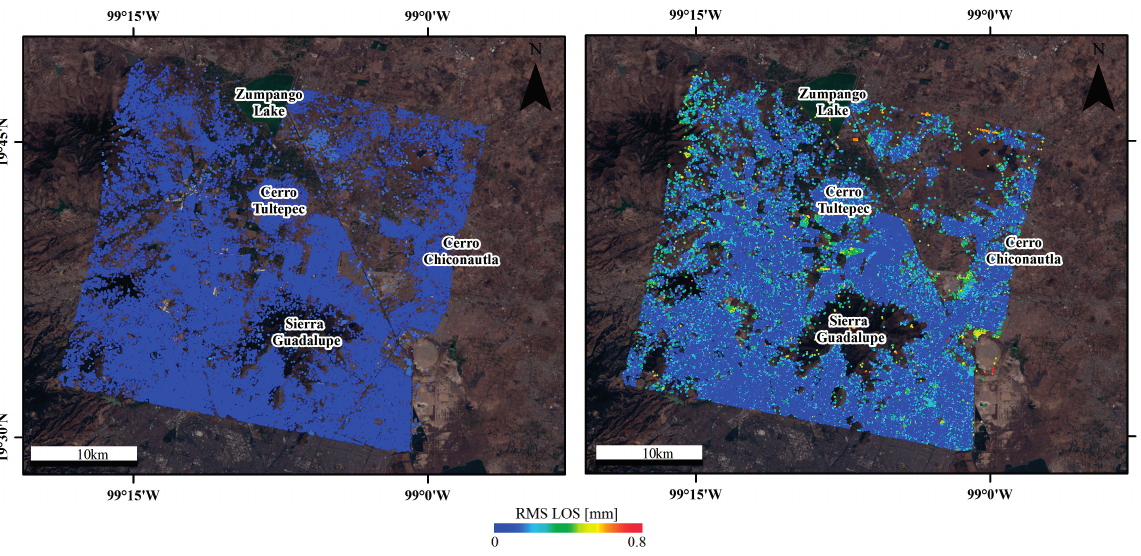
Figure 5. Histogram of the ERS and ENVISAT LOS velocities in northern ZMVM.